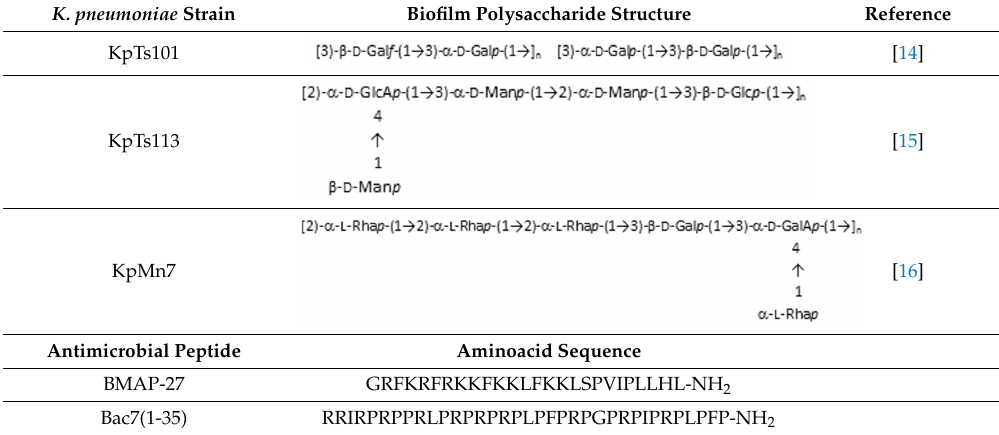
Table 1. Primary structure of the exopolysaccharides extracted from biofilms of three Klebsiella pnemoniae strains—KpTs101, KpTs113, and KpMn7—and antimicrobial peptides aminoacid sequences. K. pneumoniae Strain